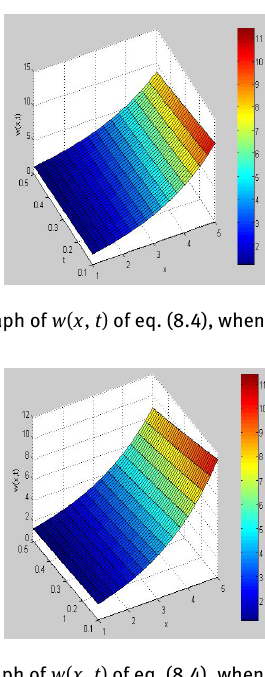
Fig. 9: Surface graph of w ( x , t ) of eq. (8.4), when α = 1 (exact solu- tion)